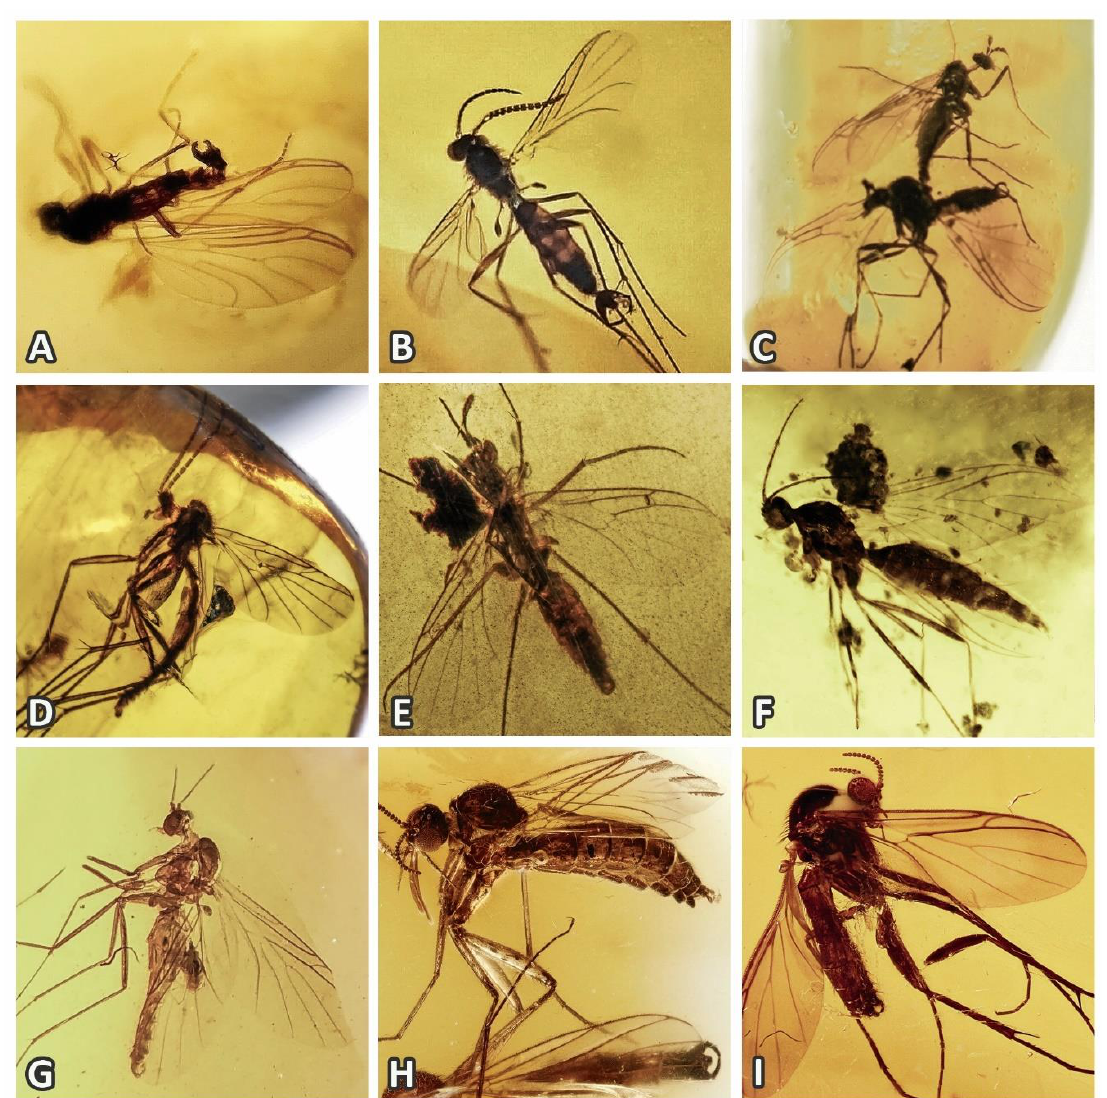
Figure 1. Examples of fossil Keroplatidae and related taxa (specimens from private collection of J. Ševčík): ( A ) Male of an undescribed Cretaceous genus of primitive Sciaroidea, representing one of possible ancestors of Keroplatidae (Burmese amber); ( B ) Male of an undescribed genus of Keroplatidae, possessing characters of both keroplatids and lygistorrhinids (Burmese amber); ( C ) Male and female of Burmazelmira sp., family Archizelmiridae (Burmese amber); ( D ) Male of Palaeoplatyura sp. (Burmese amber); ( E ) Male of an undescribed genus near Platyura (Burmese amber); ( F ) Example of a specimen possibly representing a female of Burmacrocera petiolata Cockerell, 1917 (Burmese amber); ( G ) Male of Macrocera sp. or a related genus (Burmese amber); ( H ) Male and female of Paleognoriste sp. (Baltic amber); ( I ) Male of a genus of Orfeliini (Baltic amber). All photos by J. Ševčík, except for (H) and (I) by M. Veta (www.ambertreasure4u.com).